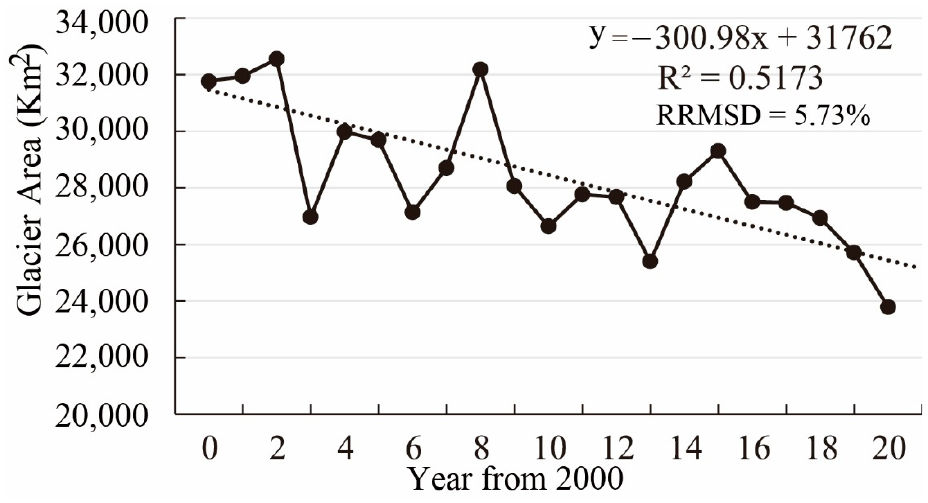
Figure 4. Annual glacier area in the Tarim Basin from 2000 to 2020 based on MODIS 500 m summer- time composite images.